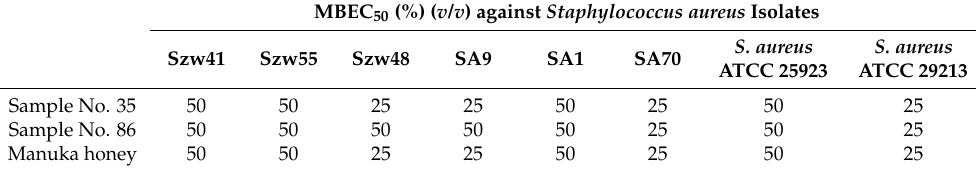
Table 4. Activity against staphylococci growing in the form of biofilm.